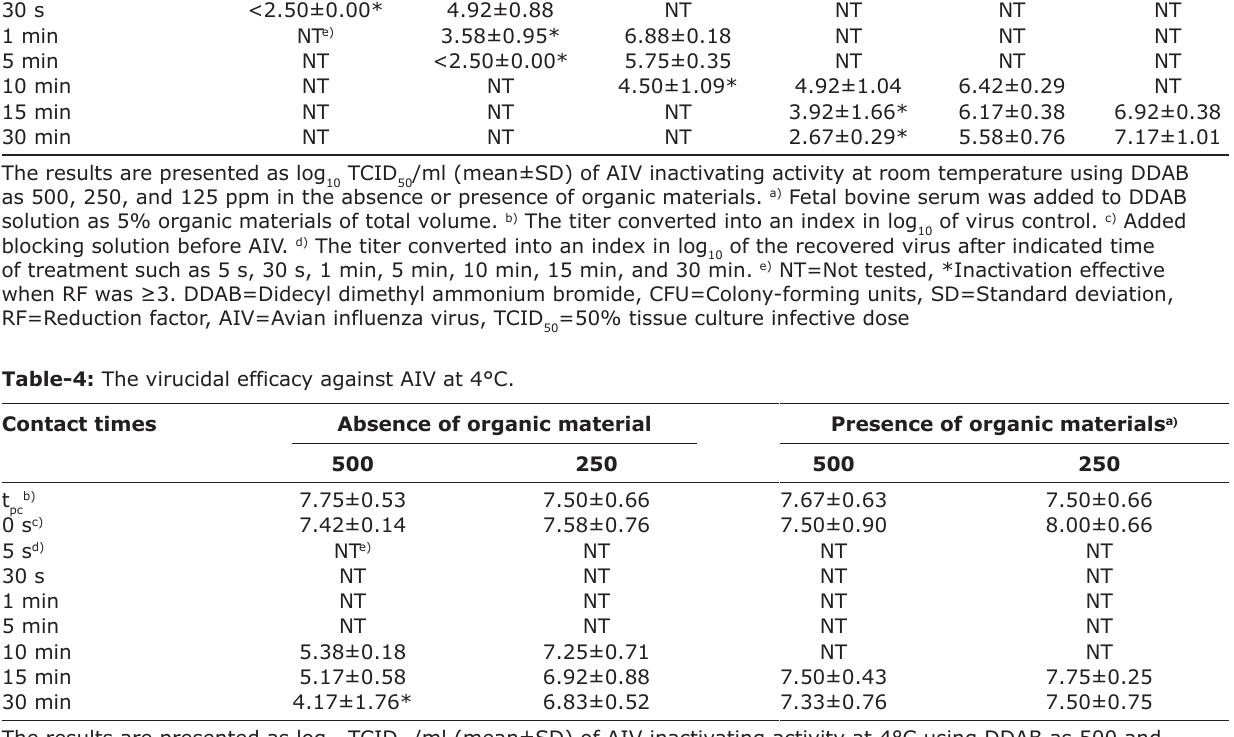
The results are presented as log TCID /ml (mean±SD) of AIV inactivating activity at 4°C using DDAB as 500 and 10 50 250 ppm in the absence or presence of organic materials. a) Fetal bovine serum was added to DDAB solution as 5% organic materials of total volume. b) The titer converted into an index in log of virus control. c) Added blocking solution 10 before AIV. d) The titer converted into an index in log of the recovered virus after indicated time of treatment 10